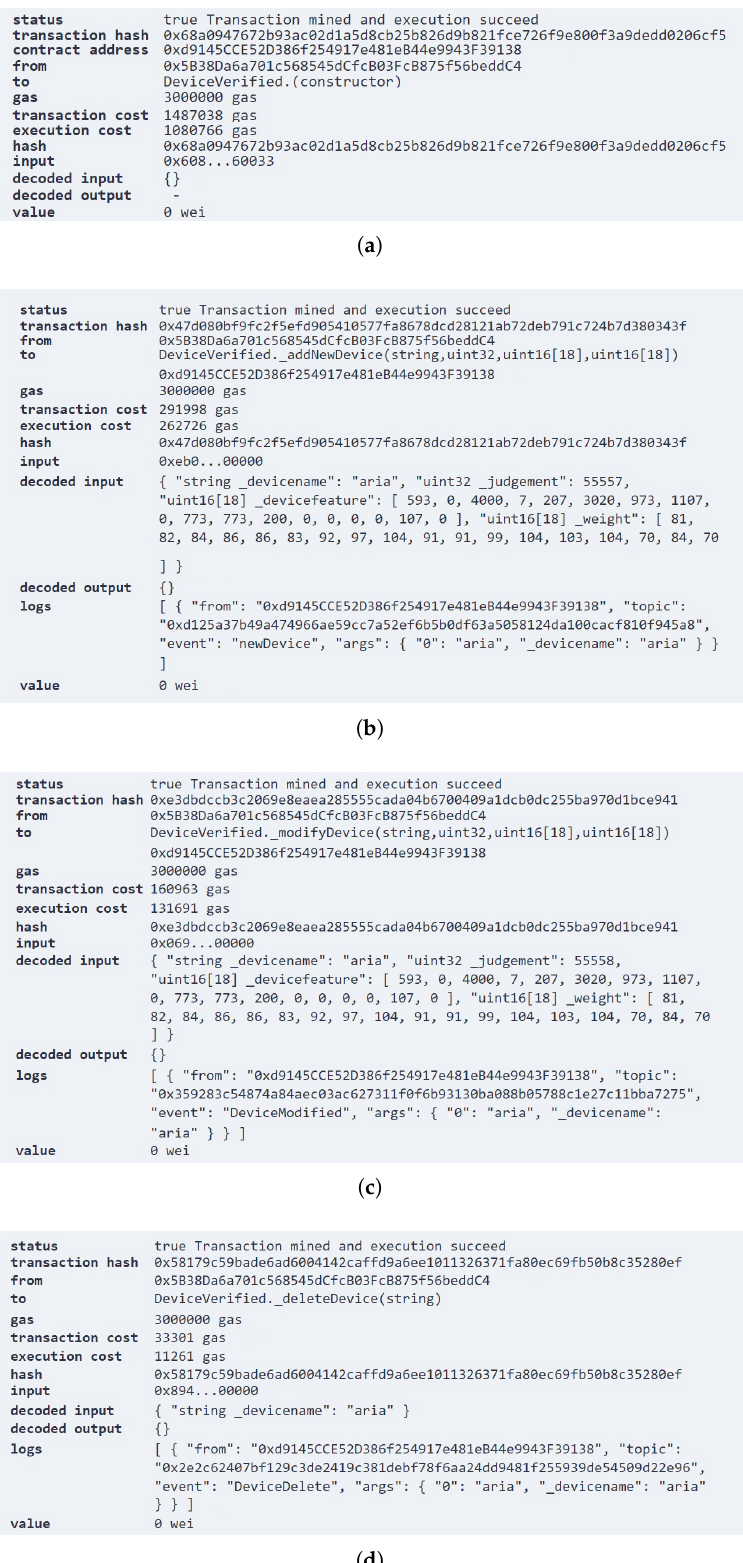
Figure 5. ( a ) Describe the result of smart contract deployment. ( b ) Describe the result of add device fingerprint to smart contract. ( c ) Describe the result of modify device fingerprint in smart contract. ( d ) Describe the result of delete device fingerprint in smart